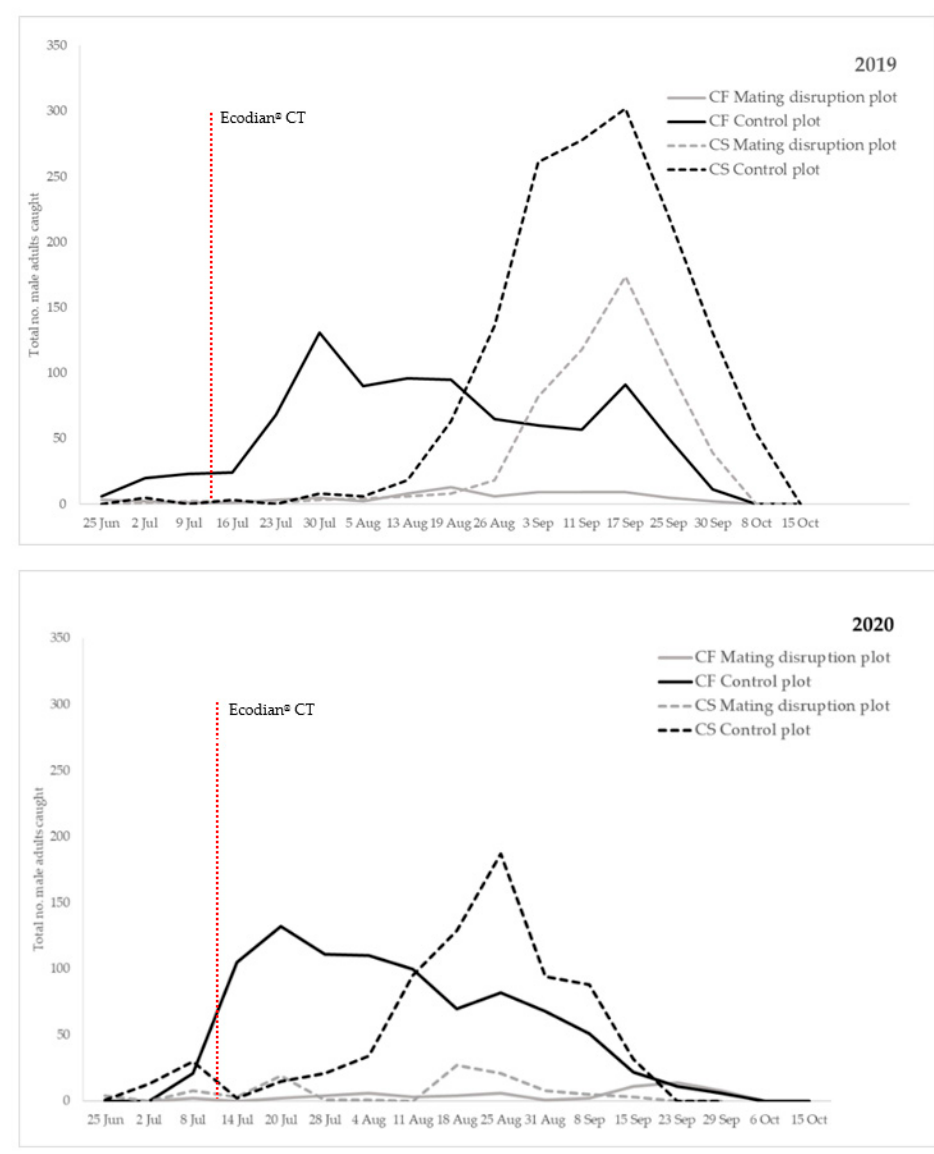
Figure 1. Total number of male adults/per week of Cydia fagiglandana (solid line) and Cydia splendana (dashed line) collected with pheromone-baited traps in all the surveyed sites, in plots where mating disruption (MD) (grey lines) was applied compared to control plots (black lines) in 2019 ( top ) and 2020 ( bottom ). The vertical dotted line corresponds to the Ecodian ® CT mating disruption application.